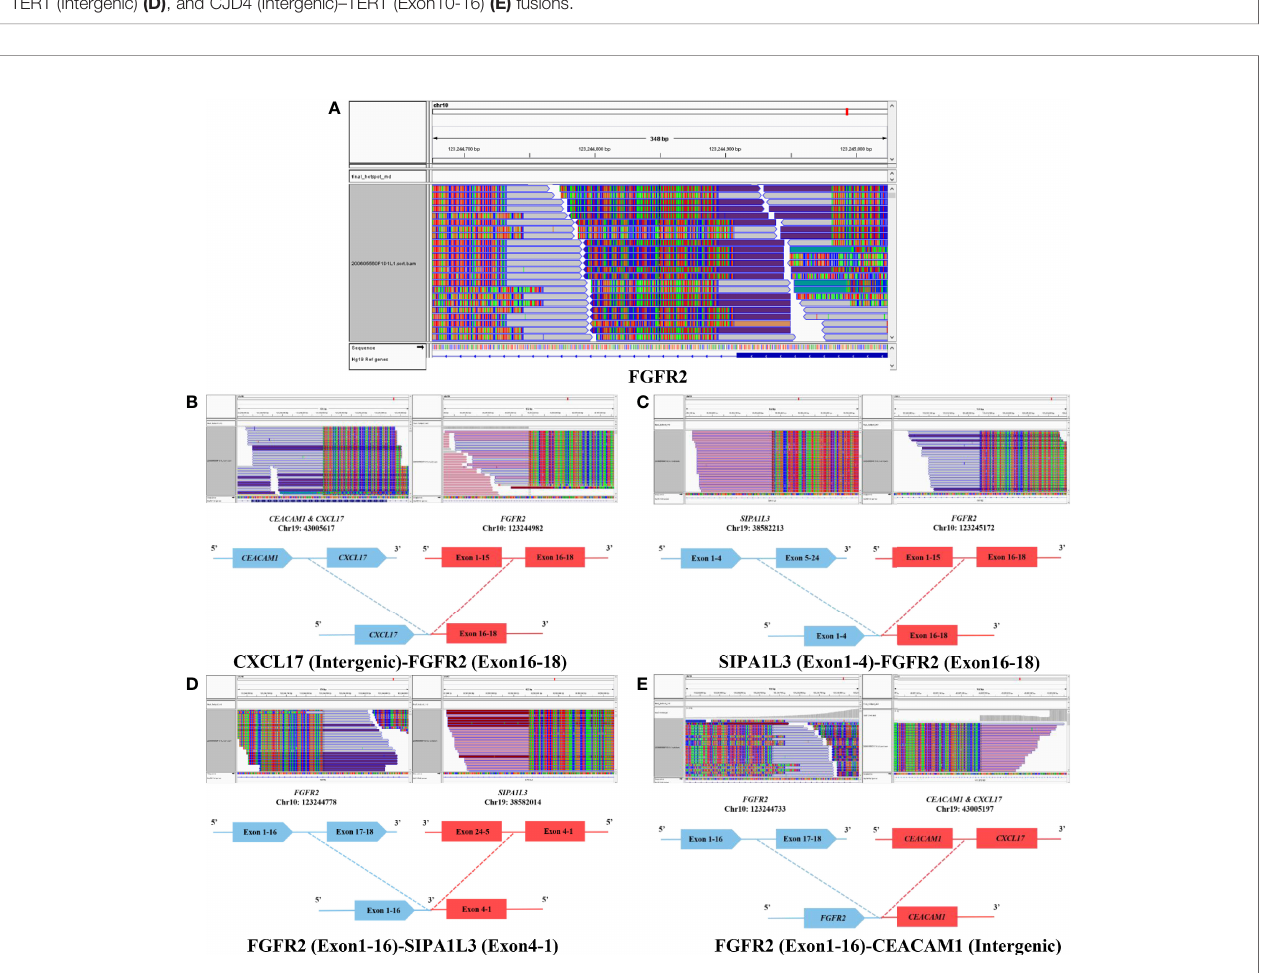
FIGURE 4 | Next generation sequencing (NGS) revealed signi fi cant FGFR2 gene rearrangement (A) , including multiple CXCL17 (Intergenic) – FGFR2 (Exon16-18) (B) , SIPA1L3 (Exon1-4) – FGFR2 (Exon16-18) (C) , FGFR2 (Exon1-16) – SIPA1L3 (Exon4-1) (D) and FGFR2 (Exon1-16) – CEACAM1 (Intergenic) (E)